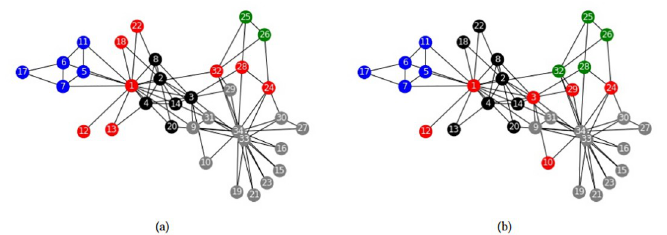
Fig 5. Zachary’s karate club community structures. Community structures obtained by (a) F ∗ with parameters n = 4, p = 2. n c = 4, p = 2, (b) F 0 c Sh (cid:0) Mod